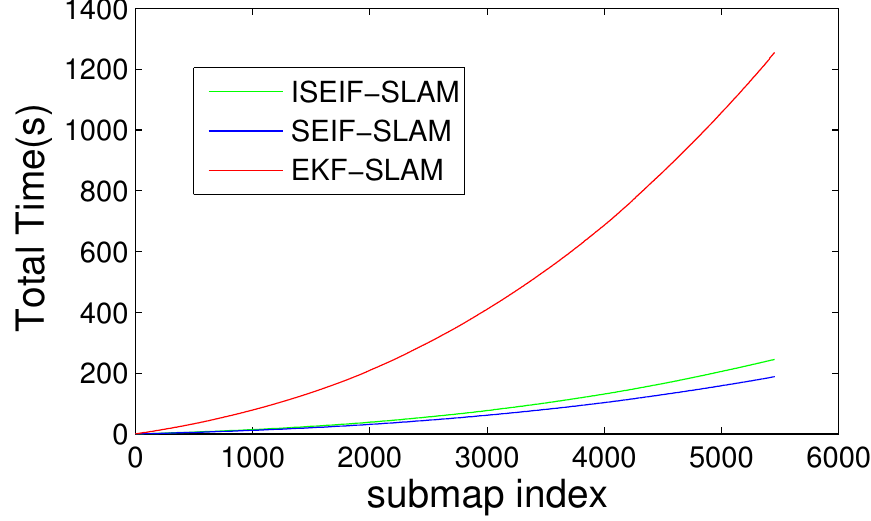
Figure 17. The comparison of CPU time for EKF, SEIF and ISEIF in the sea